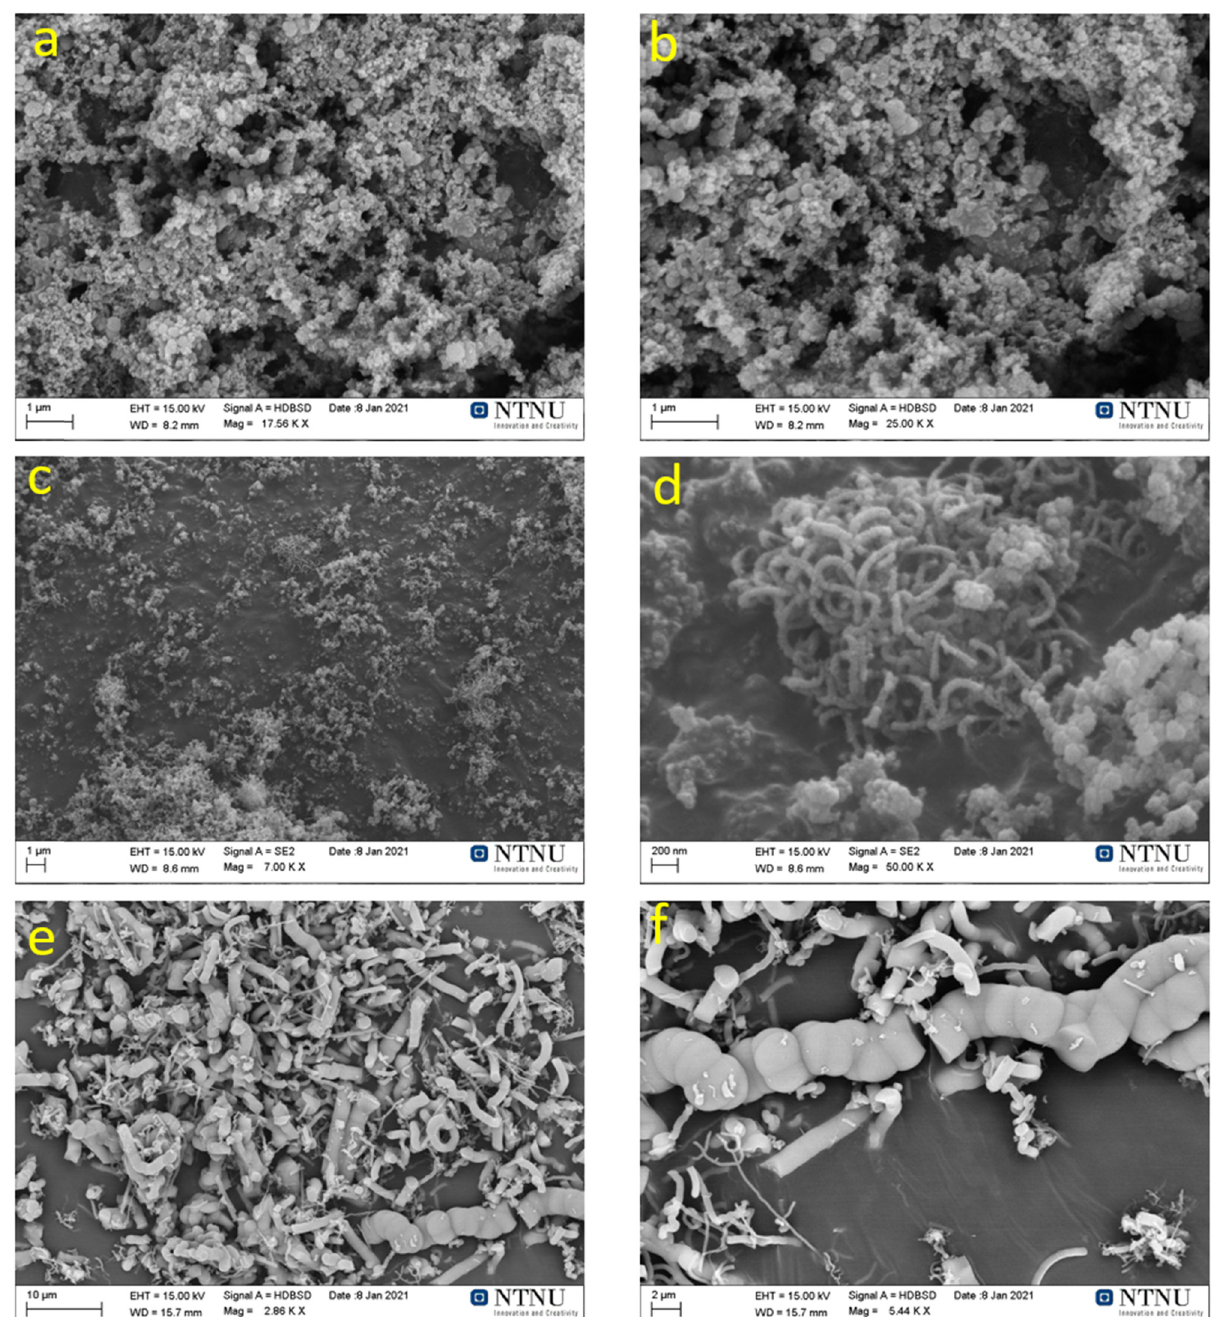
Figure 11: The SEM micrographs of the condensates settled on the gas lance: ( a ) and ( b ) He gas in the chamber, ( c ) and ( d ) Ar gas in the chamber, and ( e ) and ( f ) vacuum